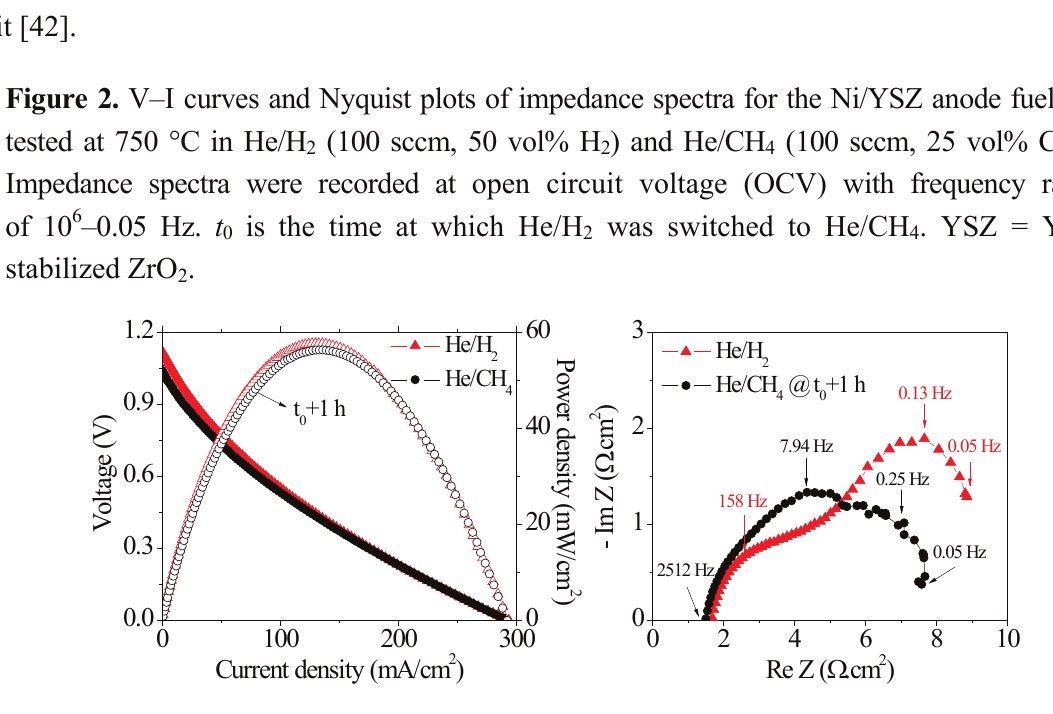
) and He/CH (100 sccm, 25 vol% CH ). 2 4 4 was switched to He/CH . YSZ = Y O 2 4 2 3